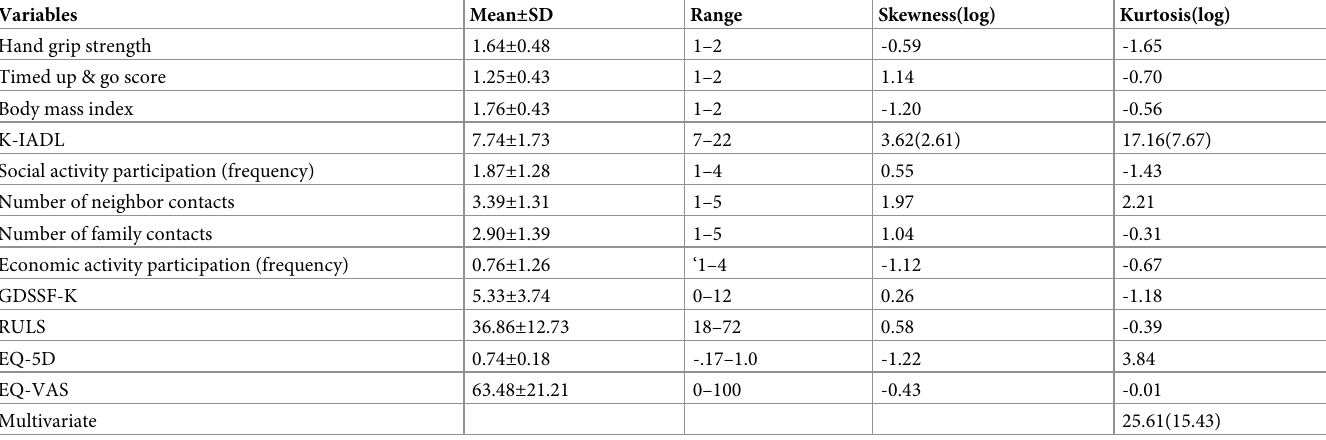
Table 2. Descriptive statistics of the observed variables (N =